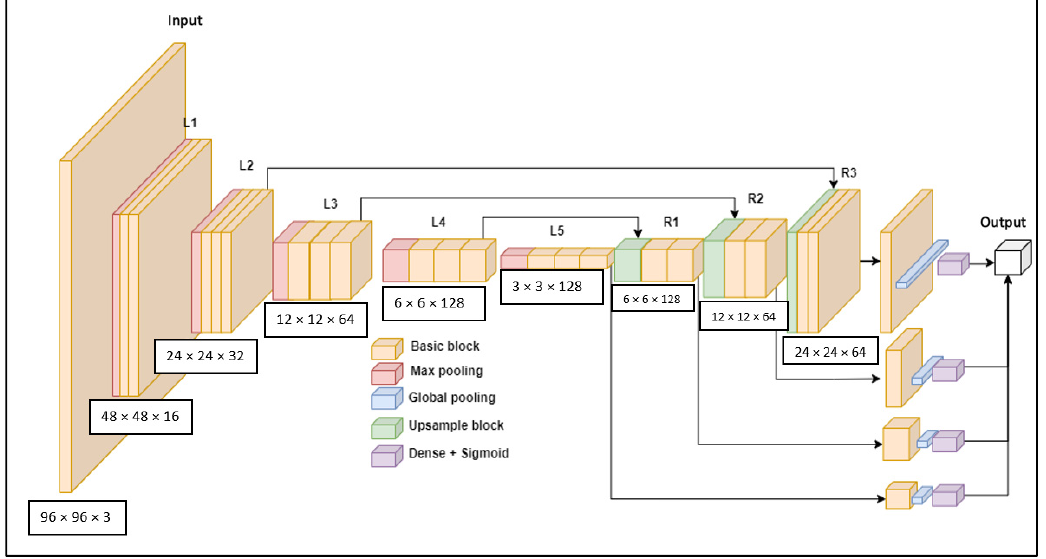
Figure 4. The M-model based on the U-Net network architecture.